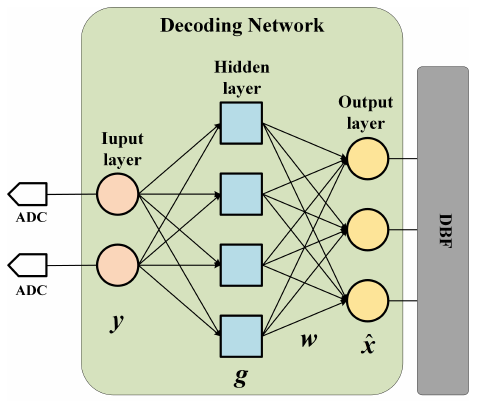
Figure A1. The structure of three-layer fully connected MLP